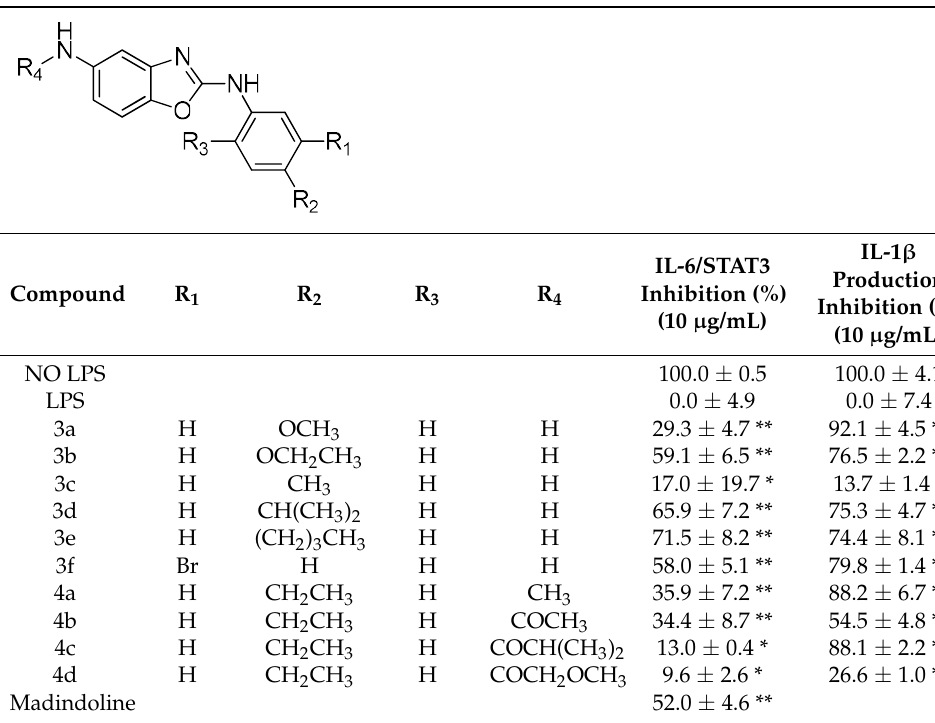
Table 1. The inhibitory effects of 2,5-diaminobenzoxazole derivatives on IL-6/STAT3 signaling and production of IL-1β from macrophages.